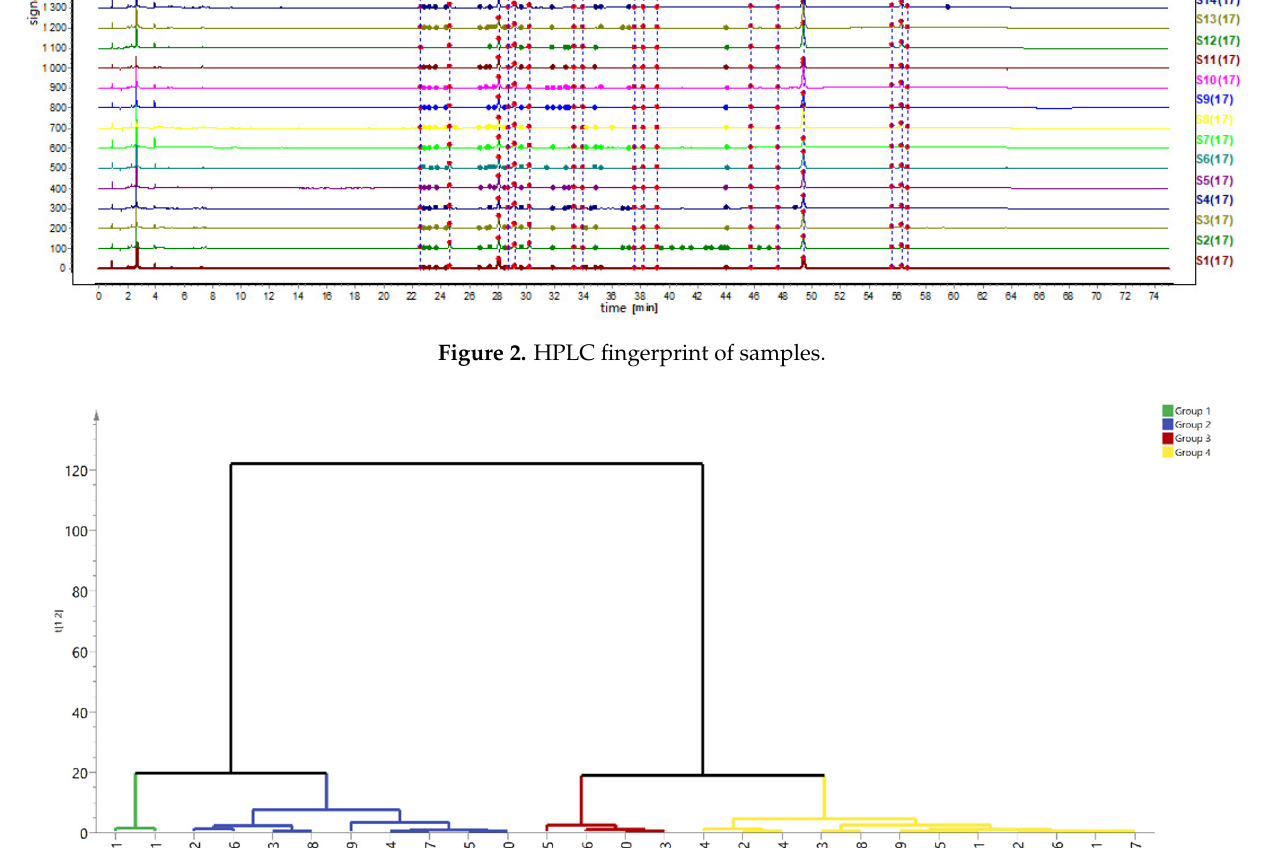
Figure 2. HPLC fingerprint of samples.